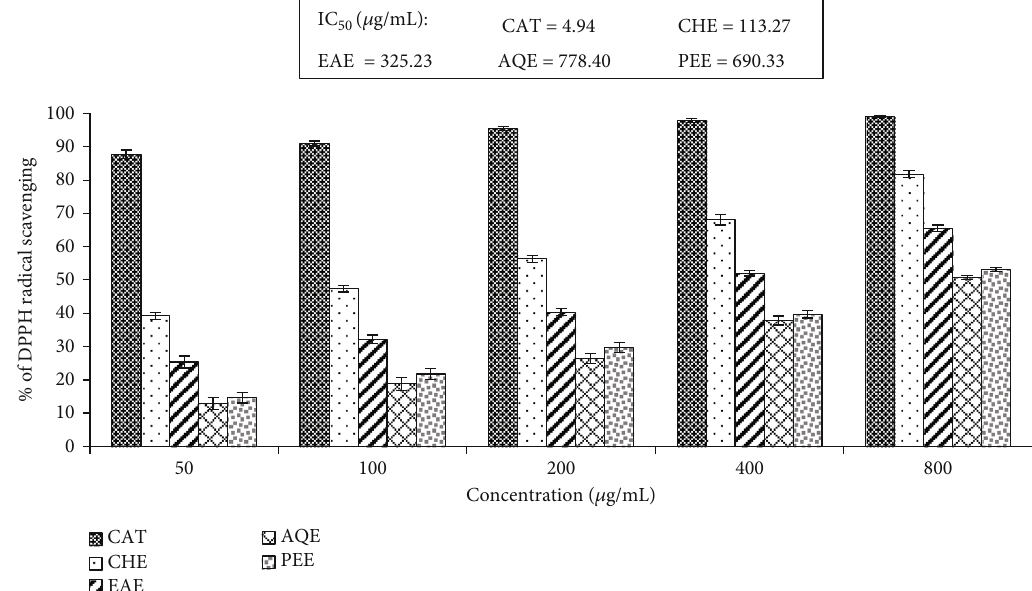
Figure 3: DPPH radical scavenging activity of di ff erent extracts of E . fl uctuans . Results represent mean ± SD ( n = 3 ). Catechin (CAT) was used as a reference standard. CHE: chloroform extract; EAE: ethyl acetate extract; AQE: aqueous extract; PEE: petroleum ether extract.